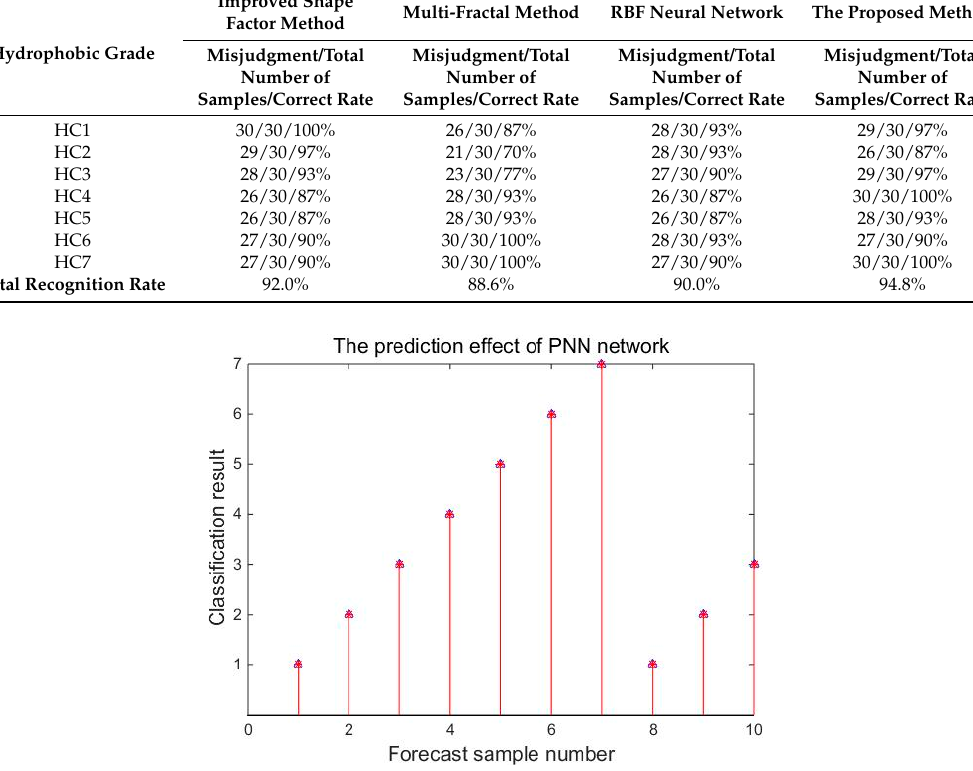
Table 5. Comparison of different classification methods.